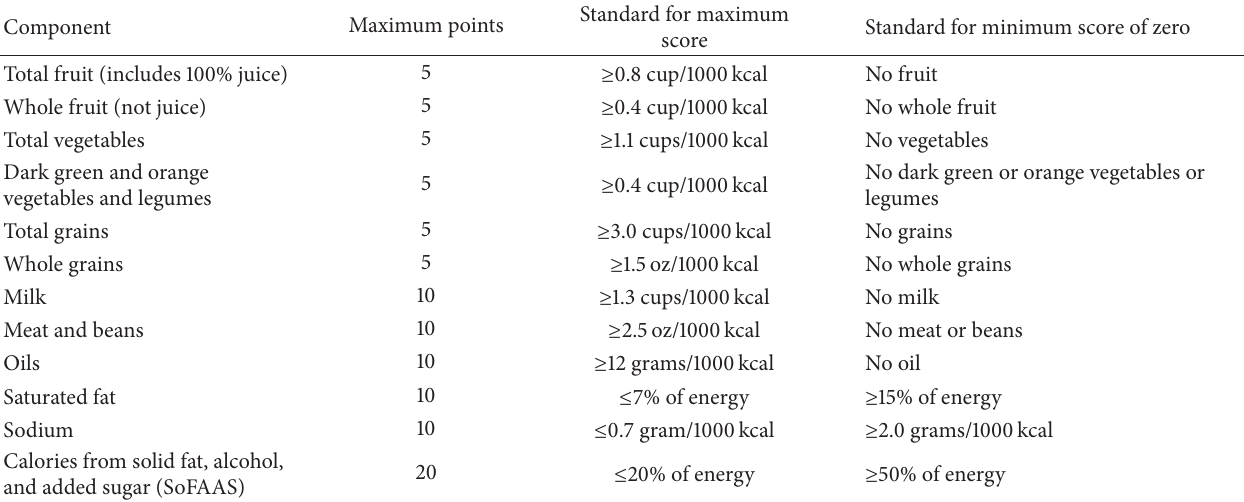
Table 6: Healthy eating index components and standards for